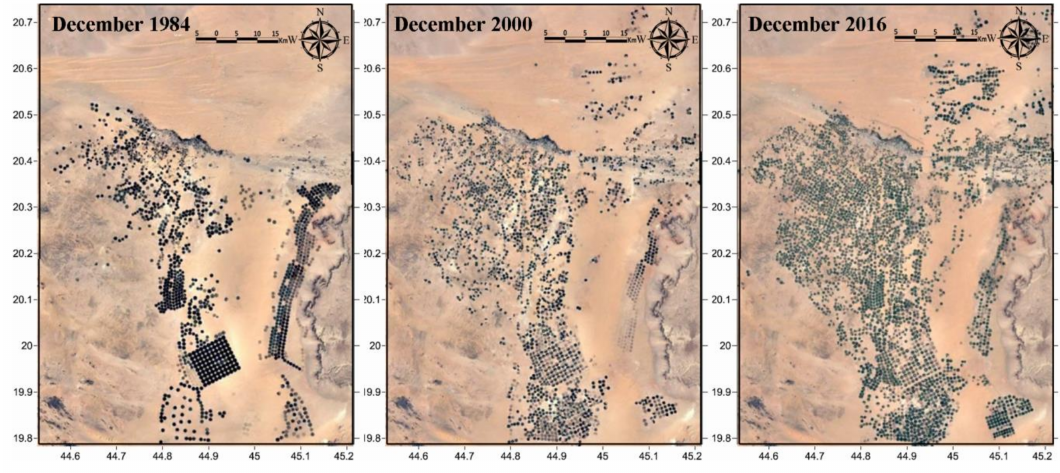
Figure 3. Agricultural expansion has been intensified six-folds in the 1984–2016